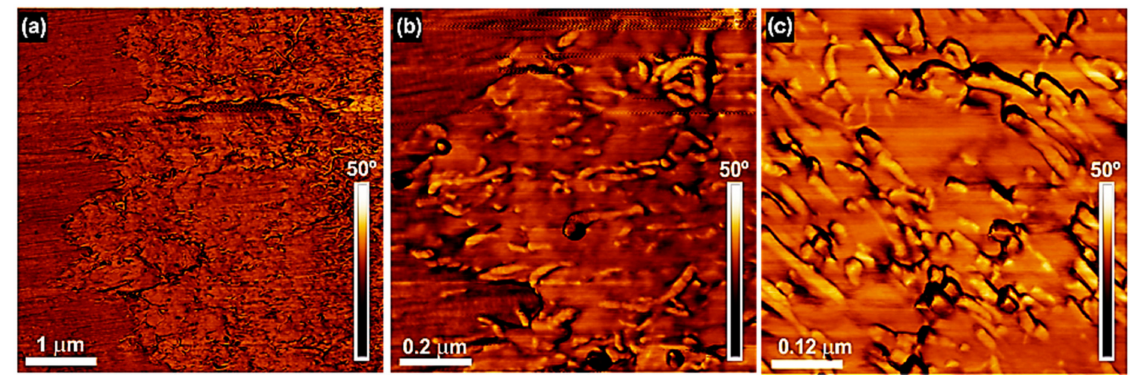
Figure 9. ( a ) Low and ( b , c ) high magnification AFM phase images for the 73/(23/4) w / w PCL/(PC/MWCNT)